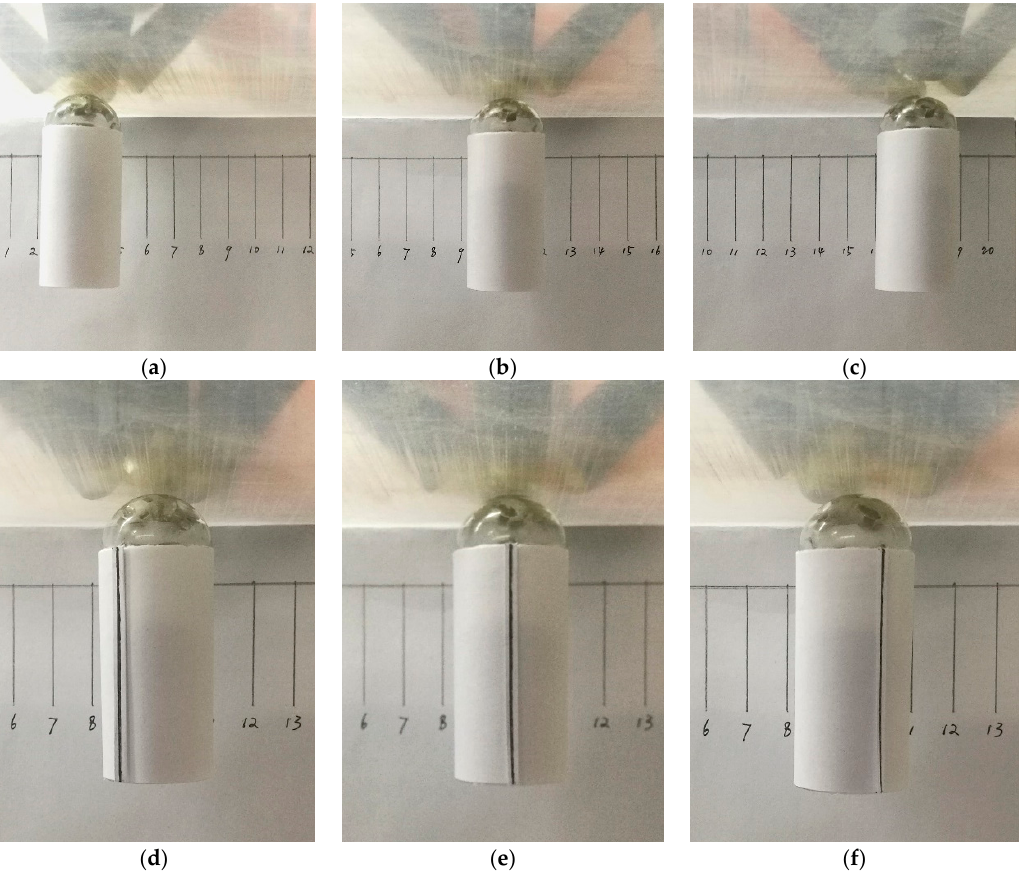
Figure 10. The translational and rotational motion of the rotor. ( a – c ) exhibit the translational motion of the rotor in different position. ( d – f ) show the rotational motion of the rotor in different angle, where a black line on the rotor surface indicate the rotational motion of the rotor.